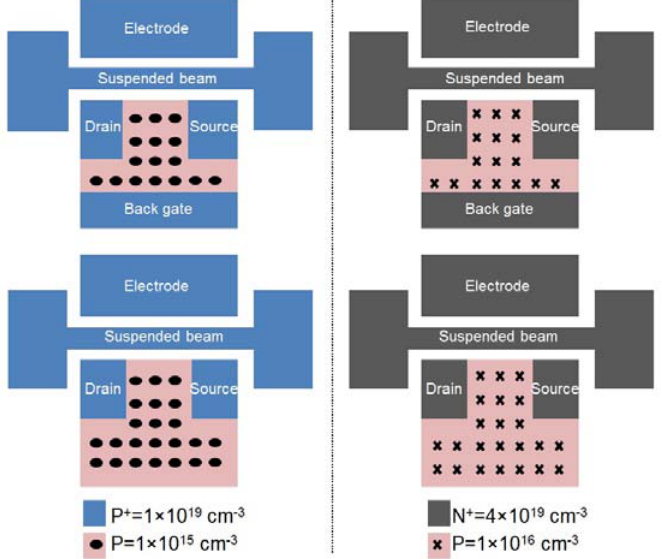
Figure 10. The doping strategies for the in-plane resonant suspended gate field-effect-transistor (IP RSG-FET) sensor: (left) P + /P/P + -type and (right) N + /P/N + -type metal-oxide-semiconductor field-effect-transistor (MOSFET) with/without the back gate on silicon-on-insulator (SOI).